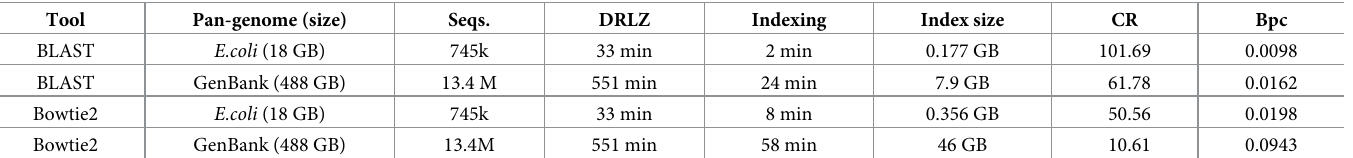
Table 4. DRLZ compression and indexing of bacterial pan-genomes with BLAST. Tool Pan-genome (size) Seqs. DRLZ Indexing Index size BLAST E.coli (18 GB) BLAST GenBank (488 GB) Bowtie2 Bowtie2 GenBank (488 GB) Bowtie2 index is created on a single node from concatenated kernel. BLAST index is created in parallel on 25 nodes from distributed kernels. The kernelization step is included in the indexing